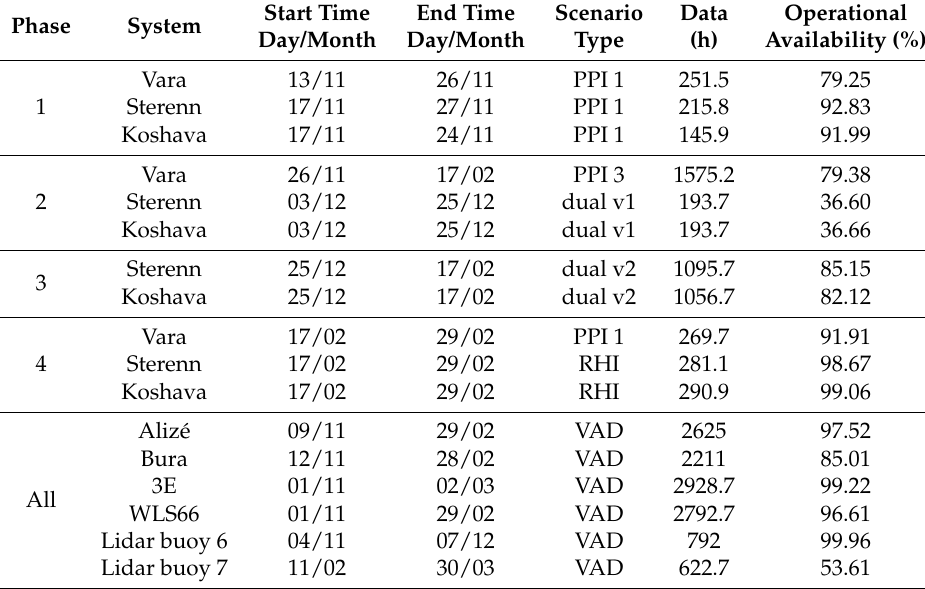
Table 2. Description of the measurement phases during the RUNE campaign. At each phase, operational availability is defined as the hours of acquired data divided by the amount of hours that the system could have acquired data. PPI 1 or 3 refers to scans with one or three elevation angles. v1 and v2 refer to the dual setup with the a larger and shorter distance between range gates, respectively. Start Time End Time Scenario Phase System